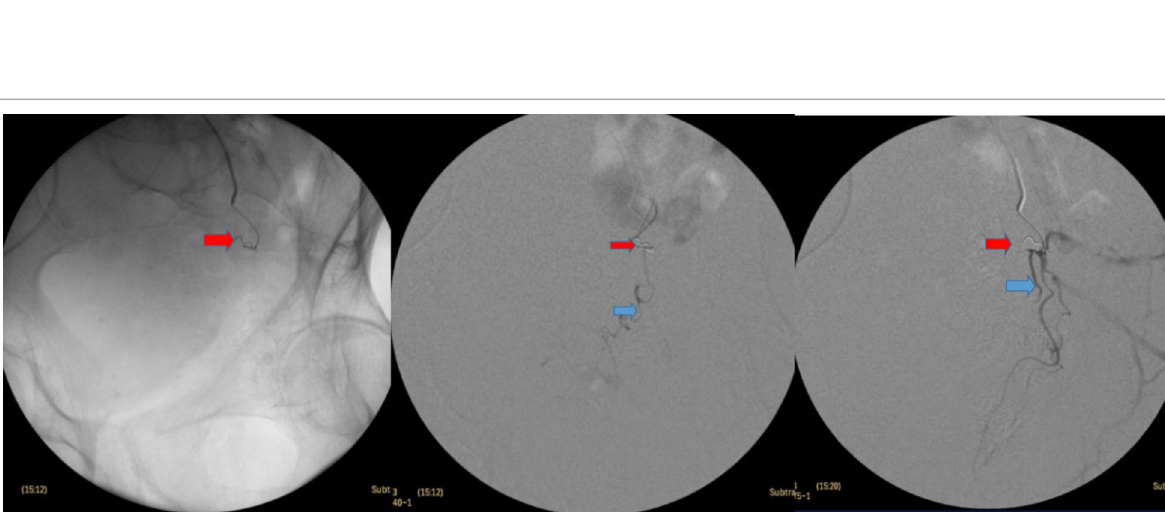
Fig. 12 Angiography images showing coil (red arrow) occluding superior vesical artery origin to avoid non‑target embolization to the urinary bladder, and prostatic artery marked by blue